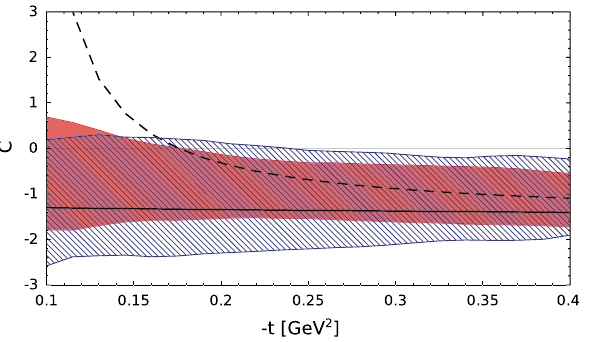
Fig. 9 Transverse target spin asymmetry A UT evaluated with LO and NLO spacelike-to-timelike relations for Q (cid:4) 2 = 4 GeV 2 , t = t 0 and E γ = 10 GeV as a function of ϕ S . The cross sections used to evaluate the asymmetry are integrated over θ ∈ (π/ 4 , 3 π/ 4 ) . For the further description see the caption of Fig.